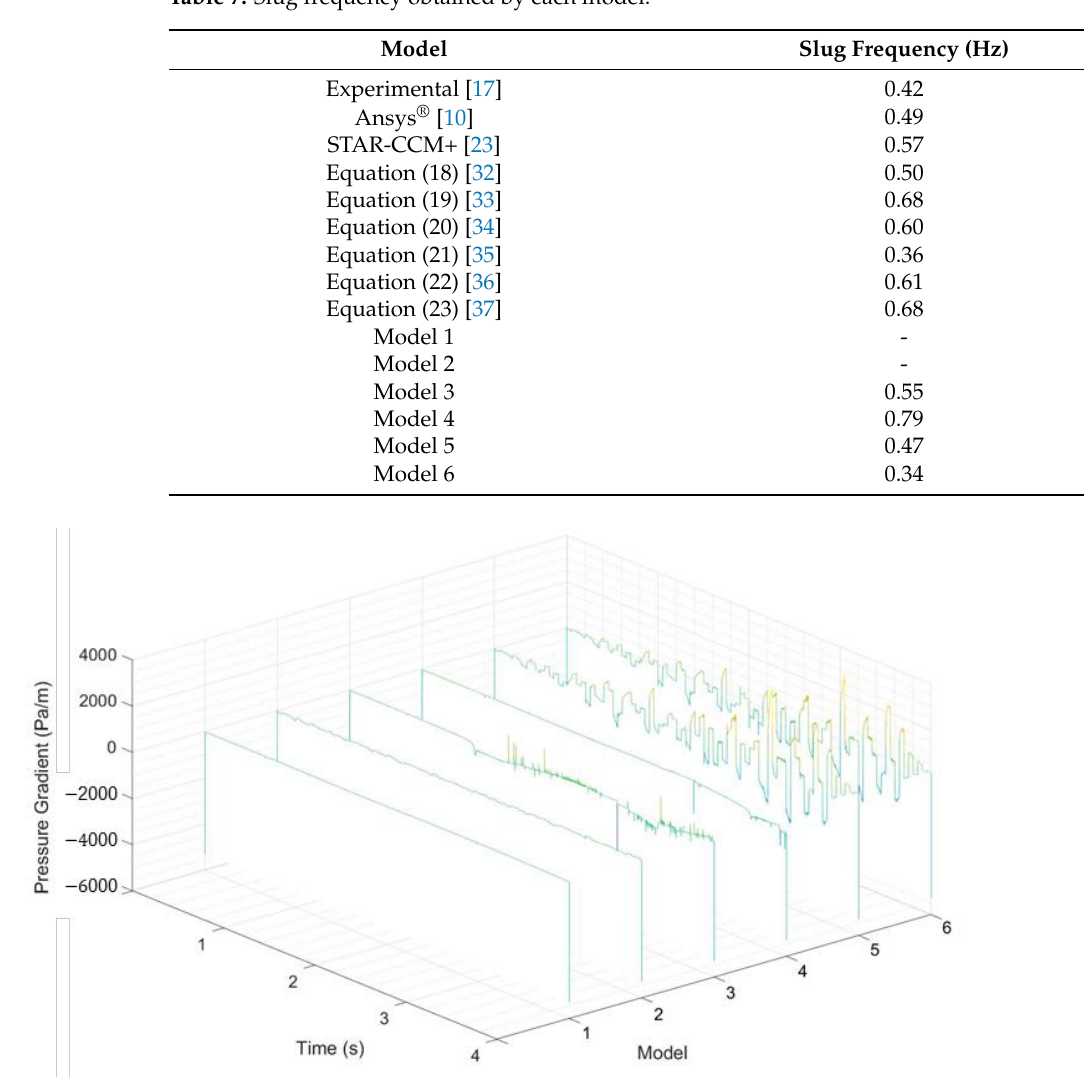
Table 7. Slug frequency obtained by each model.